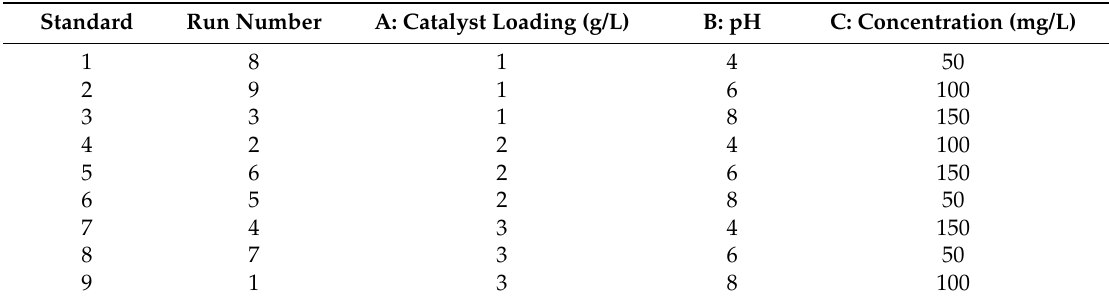
Table 10. Experimental plan using the L9 (3 4 ) orthogonal